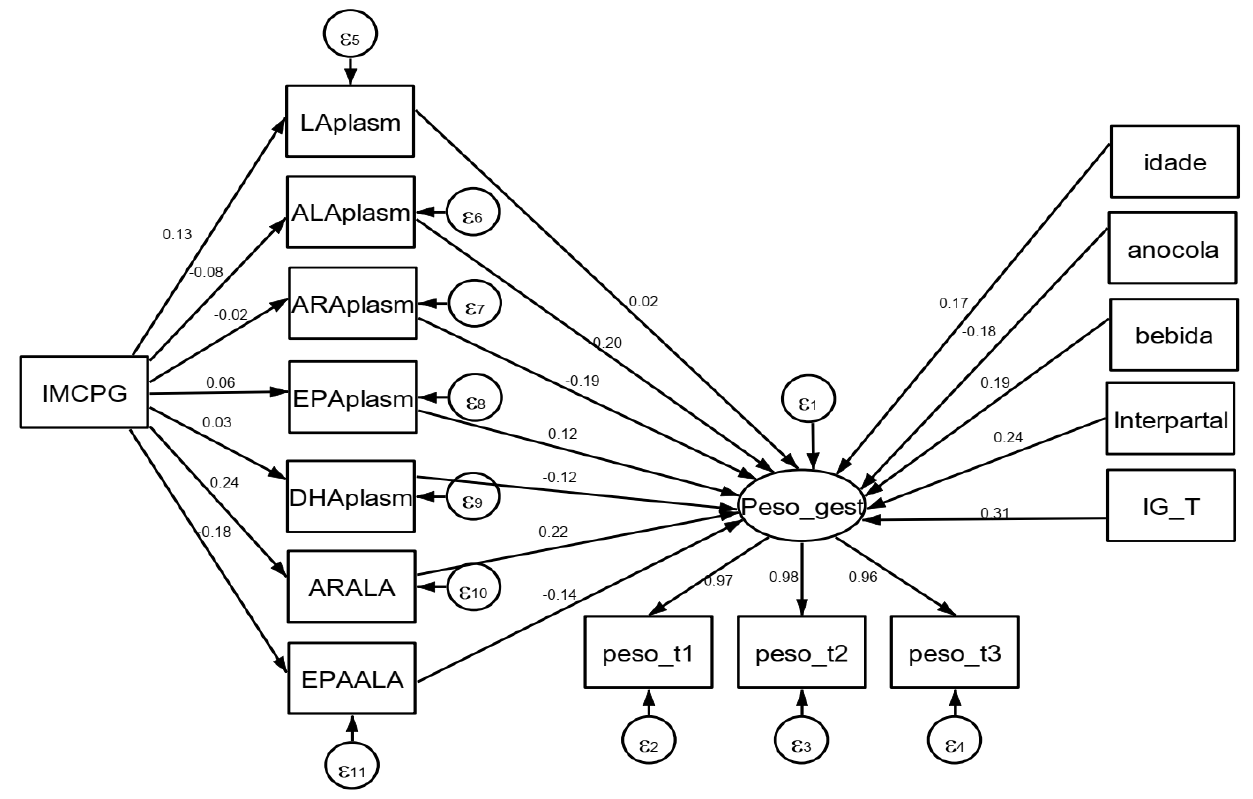
Figure 2. Structural equation modeling with the gestational weight construct and observable varia- bles. ALA: linolenic acid; LA: linoleic acid; EPA: eicosapentaenoic acid; DHA: docosahexaenoic acid; ARA: arachidonic acid; EPA/ALA: eicosapentaenoic acid to linolenic acid ratio; ARA/LA: arachidonic acid to linoleic acid ratio; IMCPG: Pre-gestational body mass index. The construct that repre- sents the weight gain throughout pregnancy (“gest_weight”) was built based on the indicator vari- ables weight_t1 (weight in the first trimester), weight_t2 (weight in the second trimester), and weight_t3 (weight in the third trimester).